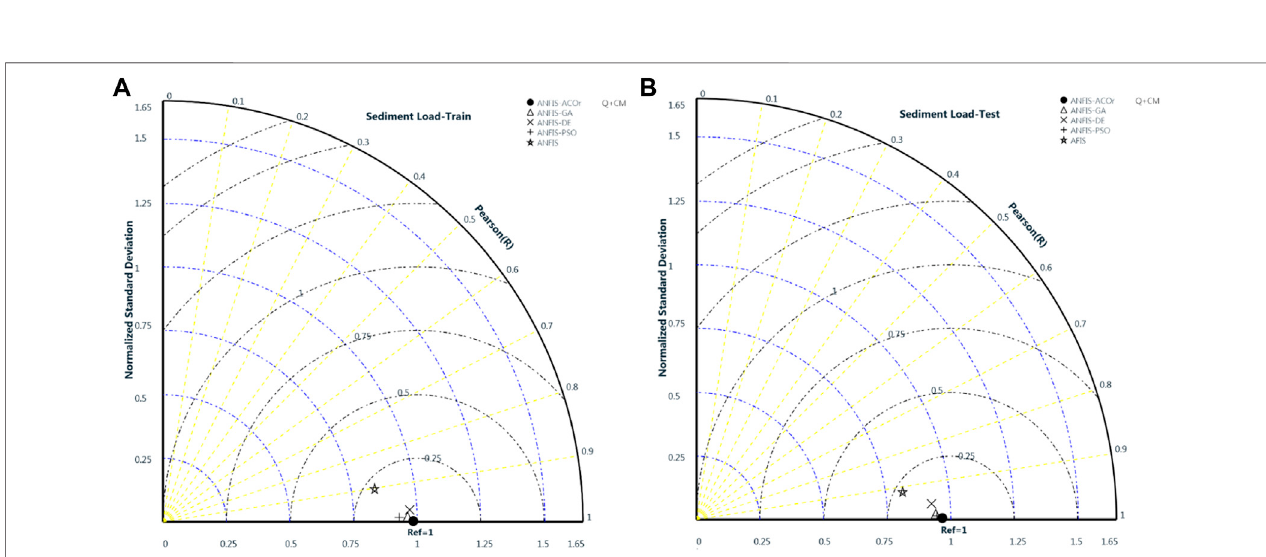
FIGURE 7 | Taylor diagram for Comparison between 5 Hybrid Algorithms in Q+CM coupled set data in (A) - Train phase and (B) - Test phase.